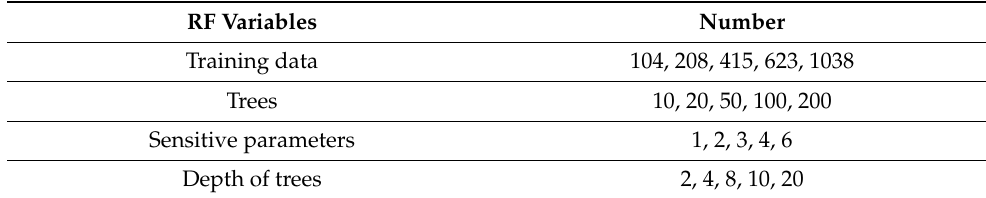
Table 7. RF variables and their